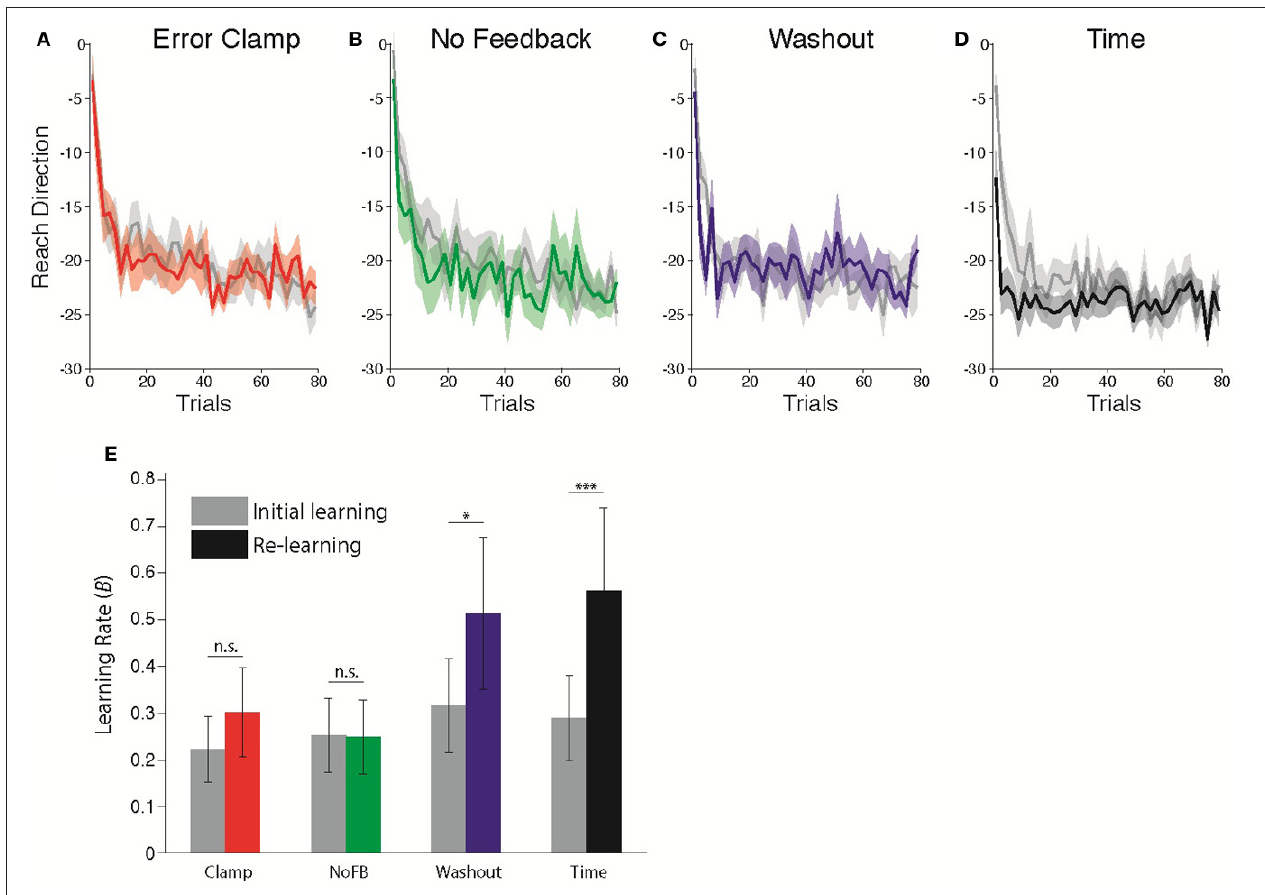
FIGURE 3 | Comparison of learning rates before and after Unlearning . (A–D) Timecourse of Initial Learning (gray) and Re-learning (colored) for (A) Clamp, (B) No Feedback, (C) Washout, and (D) Time groups. Bins of 5 trials. Shaded error bars indicate standard error in